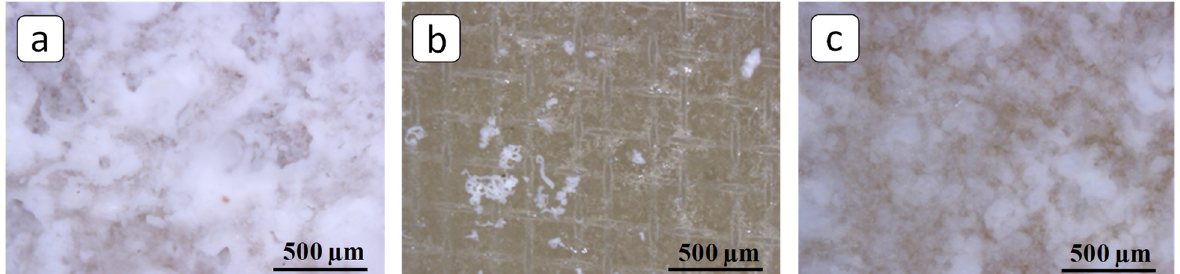
Figure 5. Optical images of the membrane surfaces facing the concentration compartment after the 3-hour experiments on the electrodialysis processing of the solutions: blank experiment ( a ), experiment in the presence of PAA-F2 ( b ) and HEDP-F ( c ).